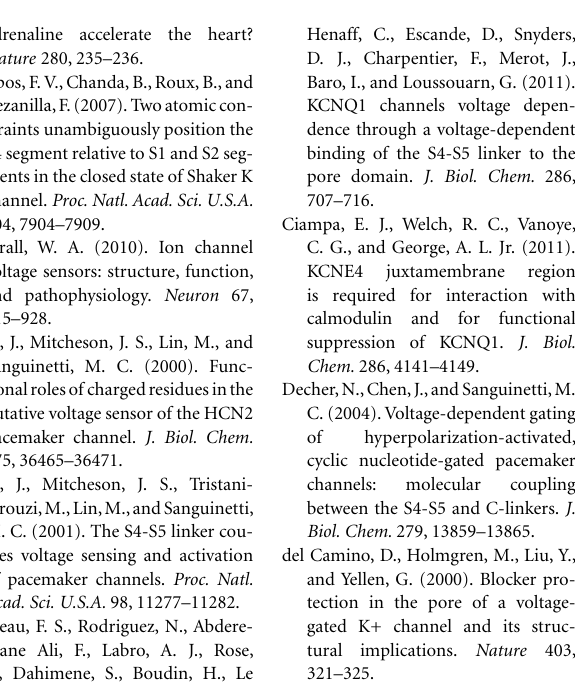
are omitted (see restriction G min < 1; Ma et al., 2011). Dashed lines correspond to a theoretical calculation based on a simple allosteric gating scheme proposed earlier (Ma et al., 2011). Parameters are as follows: HCN2 Kv = 1.2 × 10 − 3 ; Z = 2.27; b = 13.6, KCNQ1 Kv = 4.2 × 10 − 2 ; Z = 2.37; b = 1.59 × 10 3